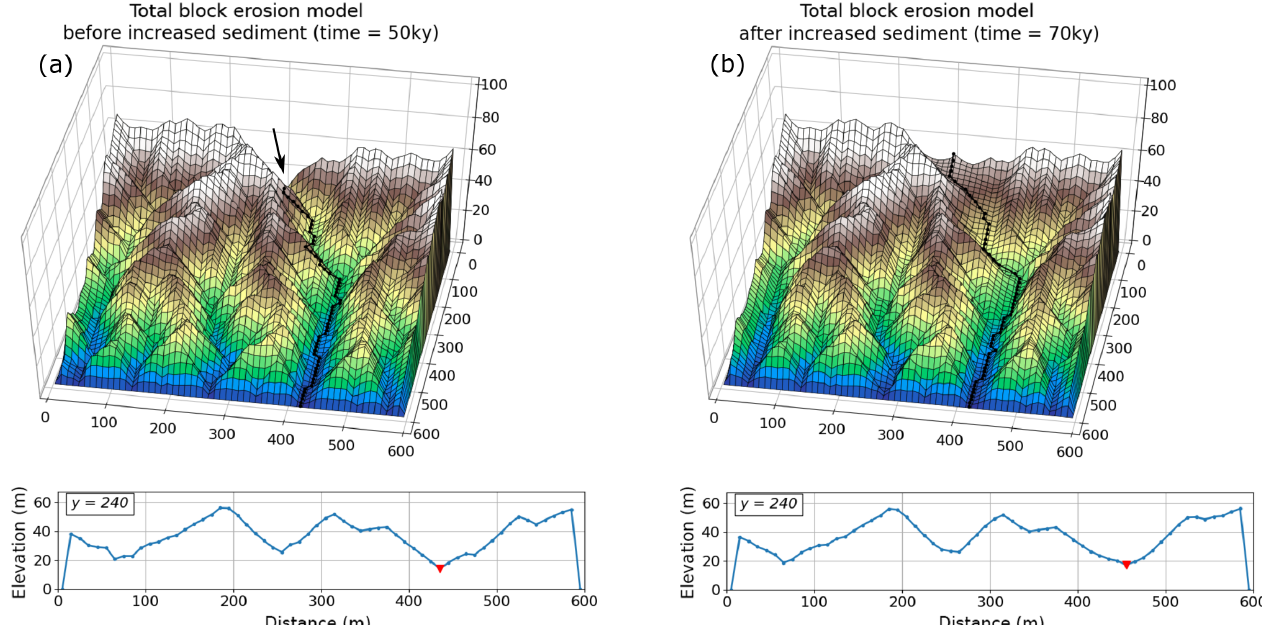
Figure 12. Model topography and cross sections at y = 420 during the period of increased sediment flux for the total block erosion model with α = 1 . 5 and K l /K v = 1 . 5. The black line indicates the position of the main channel on the landscape. The red triangle shows the position of the main channel in the cross section. (a) Before increased sediment flux is introduced at the input point, indicated with the arrow. (b) After 20kyr of increased sediment flux, the channel has aggraded by 4m and has eroded the valley wall by 30m.